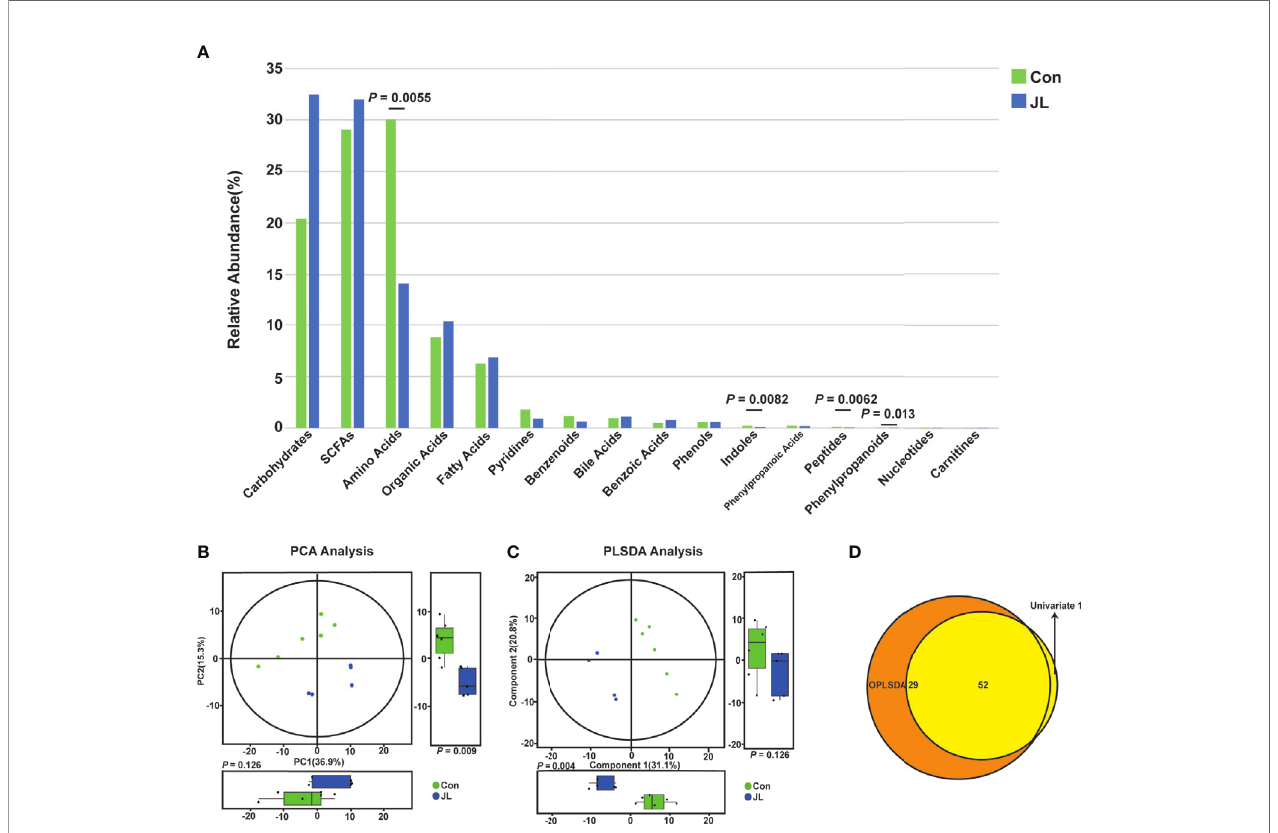
FIGURE 7 | The difference of fecal metabolites between Con (n = 6) and JL (n = 5) groups. (A) Histogram showing abundance of different kinds of fecal metabolites in two groups. Differences between two groups were assessed by student ’ s t test or Wilcoxon test. (B) PCA and difference analysis on both dimensions. (C) PLS- DA analysis on both dimensions. (D) Venn diagrams of differential metabolites screened by multi-dimensional (PLS-DA) and single-dimensional. Single-dimensional was performed by student ’ s t test or Wilcoxon